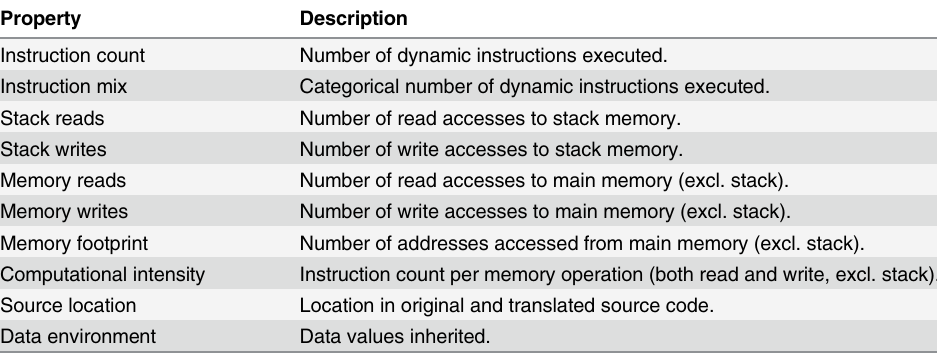
Table 2. Architecture independent per-task